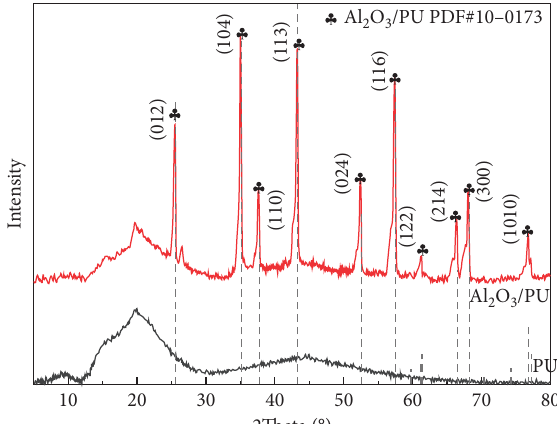
Figure 1: XRD pattern of PU foam and Al